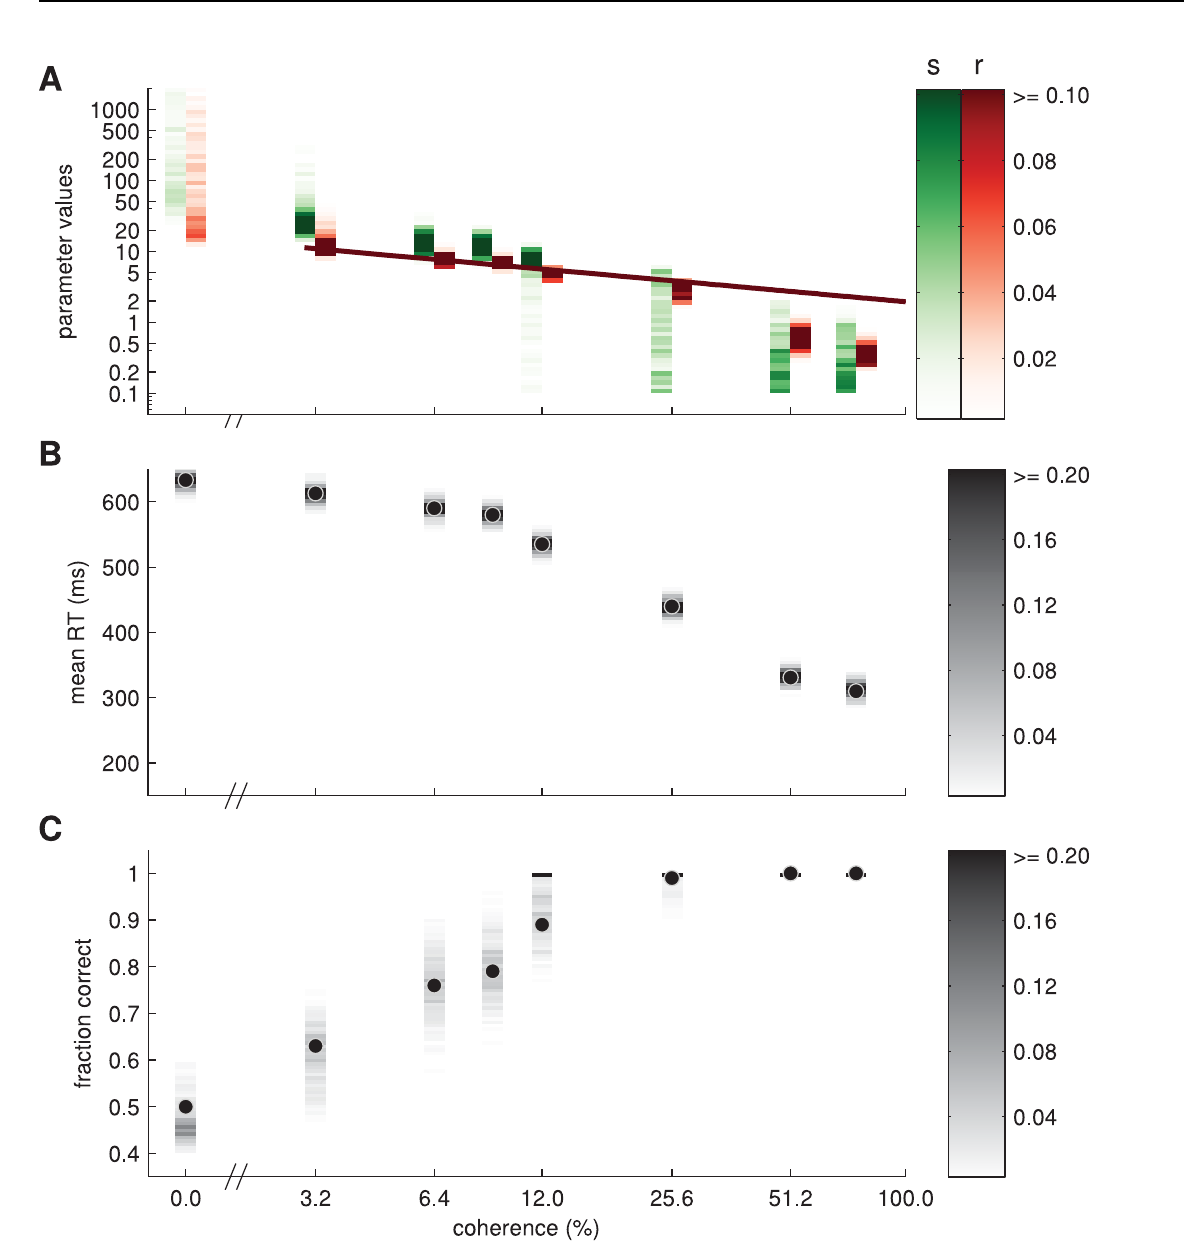
Fig 12. Model fit to experimental data presented in [54]. Eight different coherence levels ranged from 0% to 75%. (A) Model parameters (red: sensory uncertainty r , green: noise level s ) inferred from the behavioural data. For each coherence and parameter we show an approximate posterior distribution estimated from 501 posterior samples (see Methods) where darker colours correspond to larger probability as indicated by the colour bars on the right. Both abscissa and ordinate are in log-scale. Red line: linear fit between sensory variance r 2 and coherence that also exposes a linear relation between drift and coherence in the drift diffusion model. (B) Fit of mean RT of all responses. Black dots with light grey outline: behavioural data [54]. Greyscale rectangles: estimated posterior distribution over mean reaction time. (C) Fit of accuracy (fraction of correct responses). Format as in B. Black, horizontal bars for coherences greater than 9% indicate probabilities larger than 0.2 for an accuracy of 1. This means that for high coherences parameter values as indicated in A predicted an accuracy of